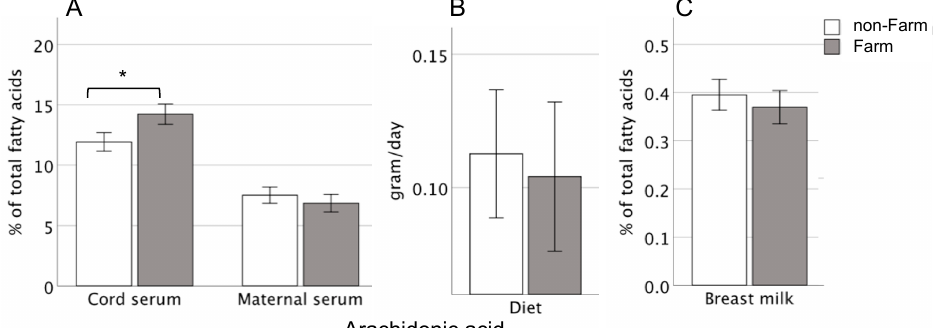
Figure 1. Proportions of arachidonic acid among the total fatty acids in: ( A ) cord serum obtained at delivery from infants and in maternal serum obtained post-partum, from non-farming control (open bars) or farming (filled gray bars) families. ( B ) The maternal diet 1 month post-partum; and ( C ) breast milk obtained around 1 month post-partum. Differences in the proportions of arachidonic acid between samples from Farm and non-Farm subjects were calculated using the Mann-Whitney U -test. Error bars are mean +/ − 2 SE; *: p <